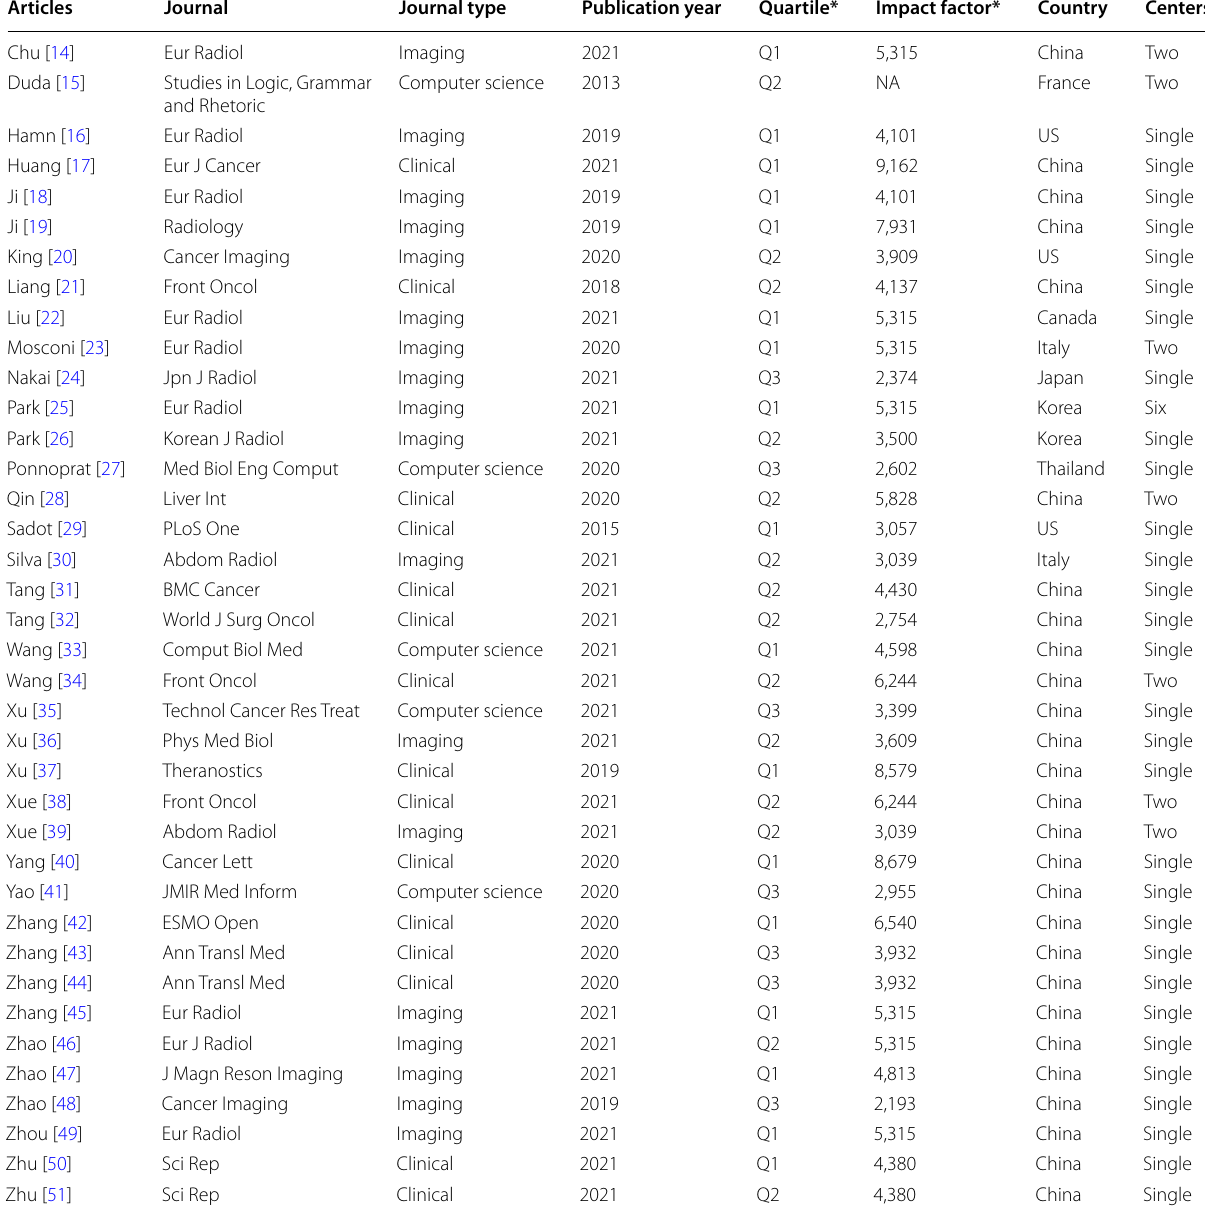
Table 1 General characteristics of the included